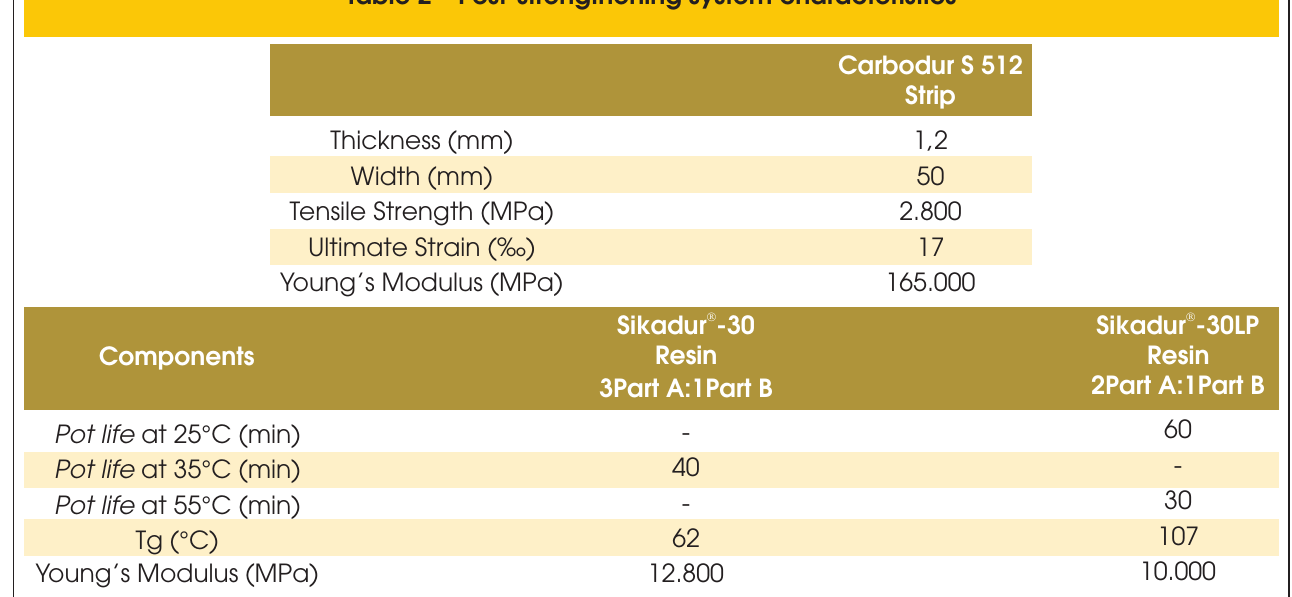
Table 2 – Post-strengthening system